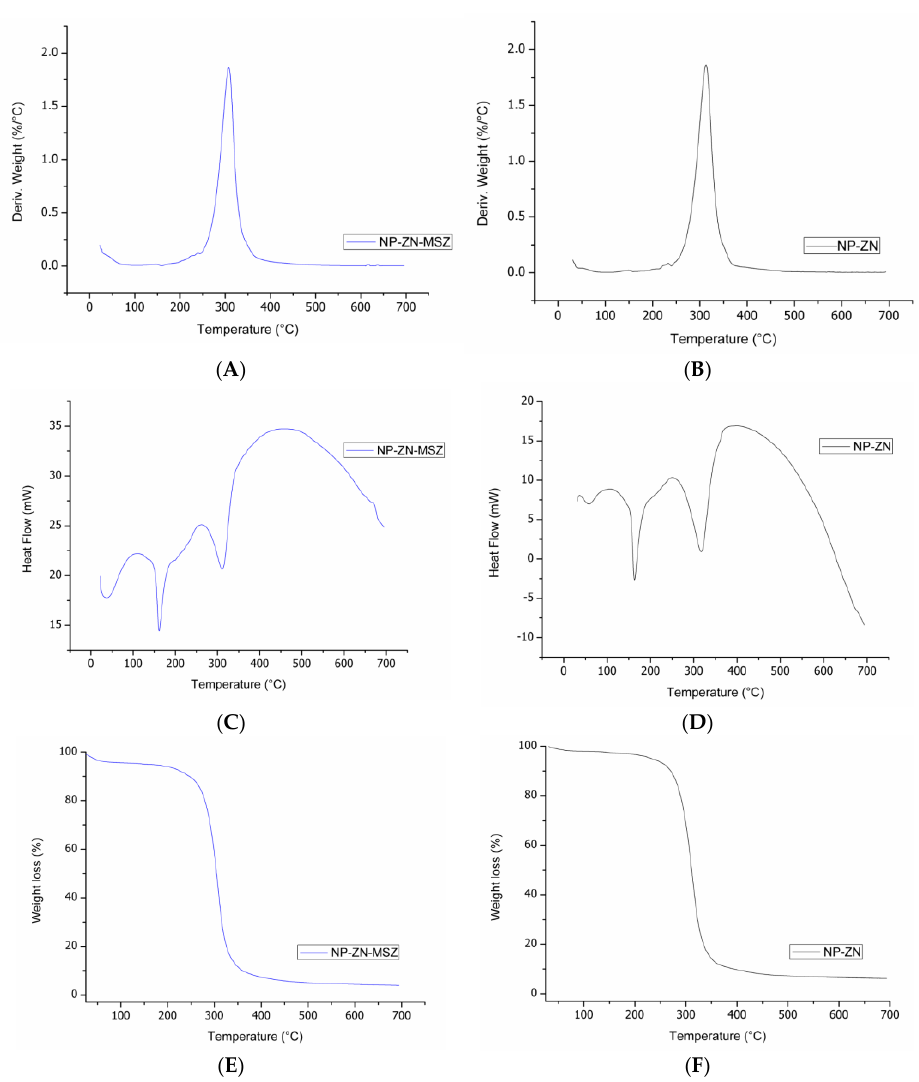
Figure 7. Thermogram of NP-ZN-MSZ ( A , C , E ) and NP-ZN ( B , D , F ). Pharmaceutics 2022 , 14 , x FOR PEER REVIEW